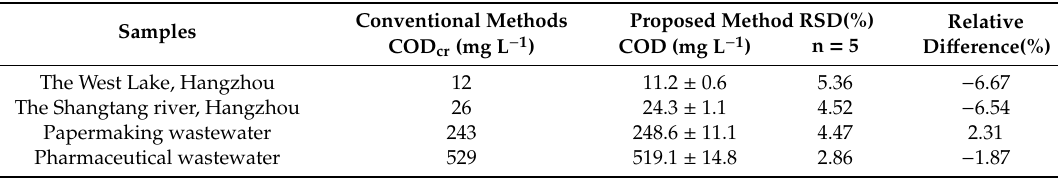
Table 2. Measurement results for real water samples by CuO / CuNWE-based electrochemical method and standard dichromate method.